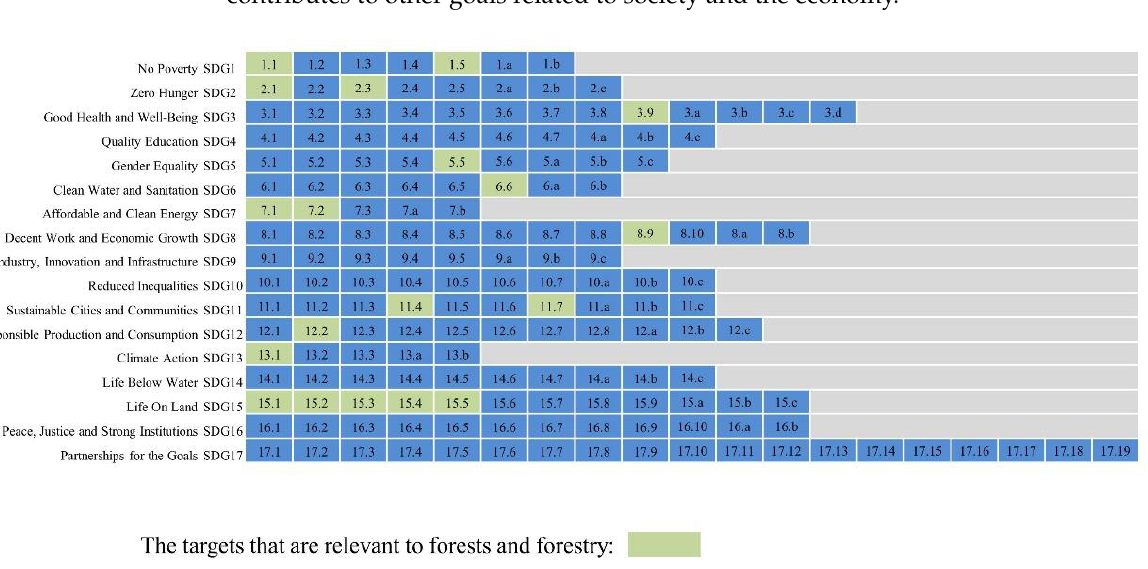
Figure 1. Research framework design .